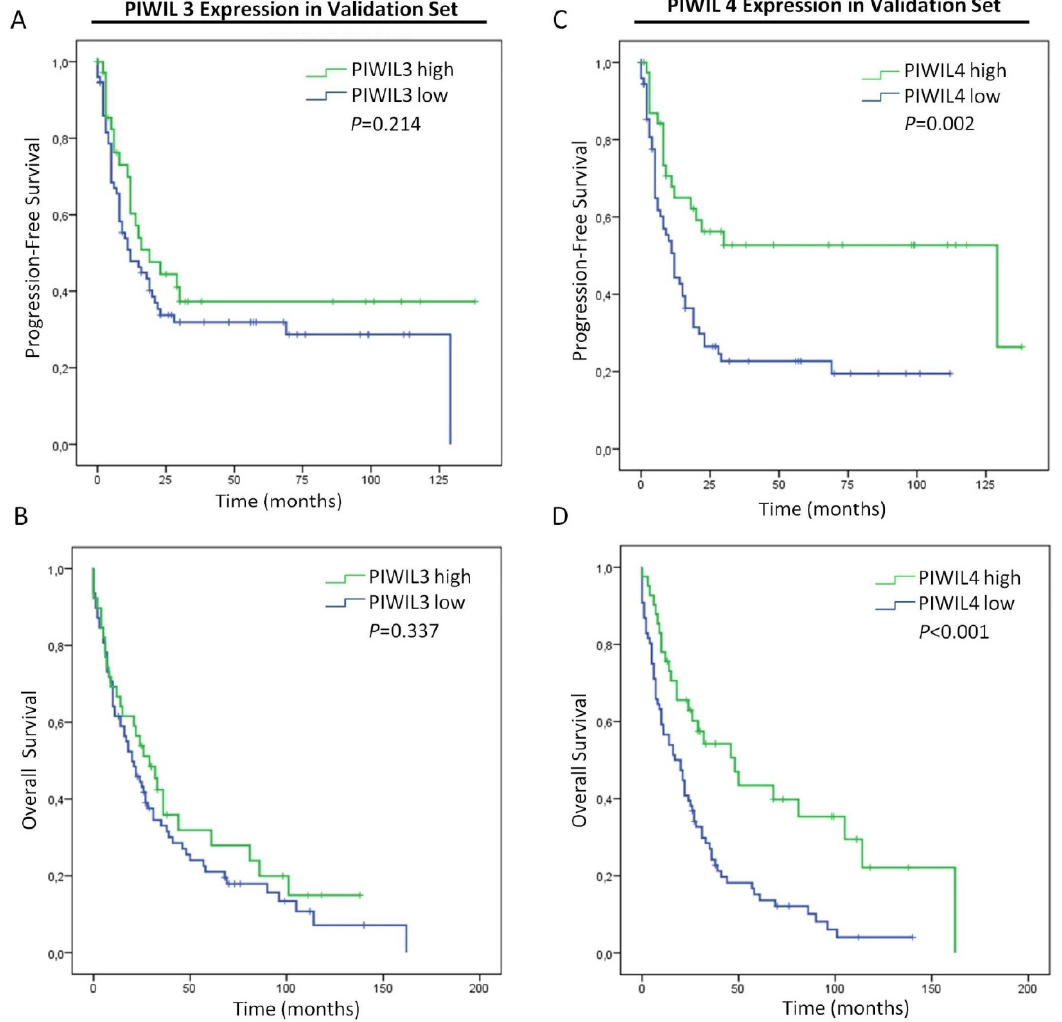
Figure 6. Prognostic impact of PIWIL3 or PIWIL4 in PC patients from the validation set. ( A ) Kaplan–Meier curves according to PIWIL3 protein expression for progression-free survival. ( B ) Kaplan–Meier curves according to PIWIL3 protein expression for overall survival. ( C ) Kaplan–Meier curves according to PIWIL4 protein expression for progression-free survival. ( D ) Kaplan–Meier curves according to PIWIL4 protein expression for overall survival. p -values were obtained by log-rank test.